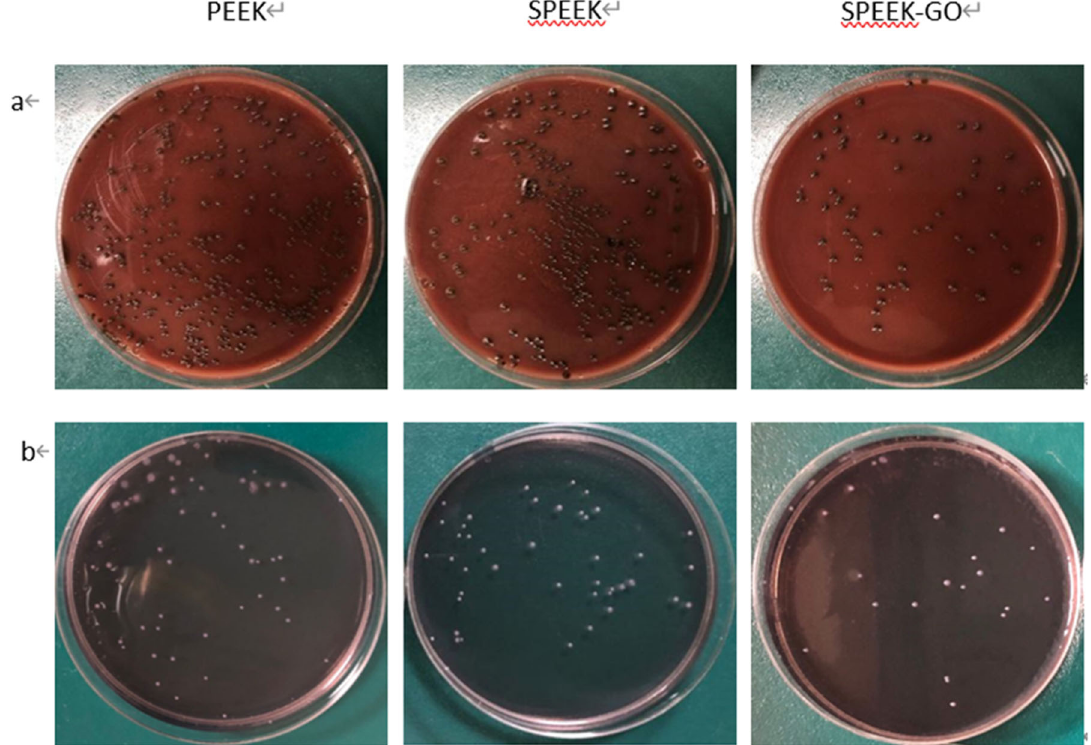
Fig. 7 Antibacterial results of PEEK, SPEEK, and SPEEK-GO against P. gingivalis ( a ) and S. mutans ( b ). It is observed that the SPEEK-GO specimens exhibited the strongest antibacterial effect